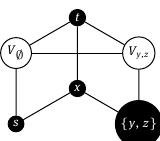
Figure 8: Structure of case (a). Here V x = { s , t } , where s is not adjacent with any vertex in V y , z , and t is adjacent with each vertex in V y , z